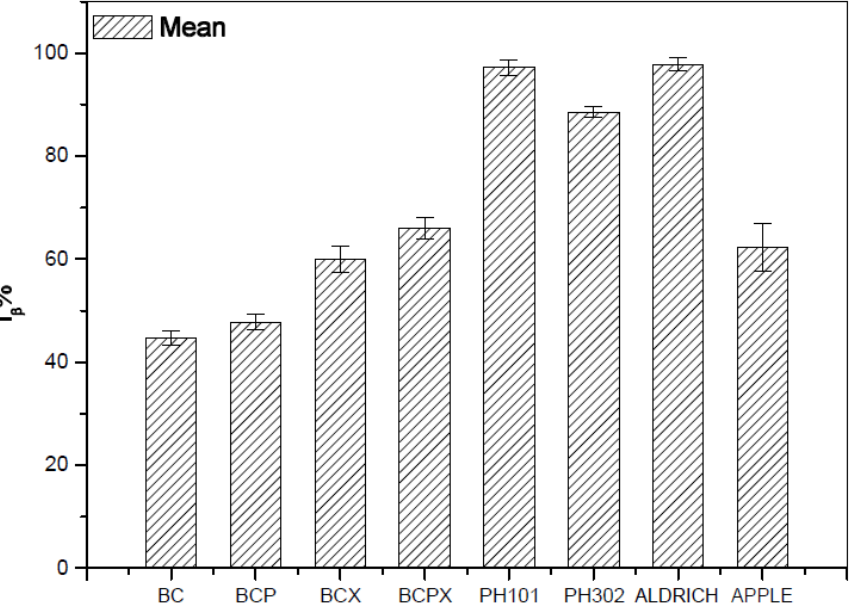
for celluloses from different β